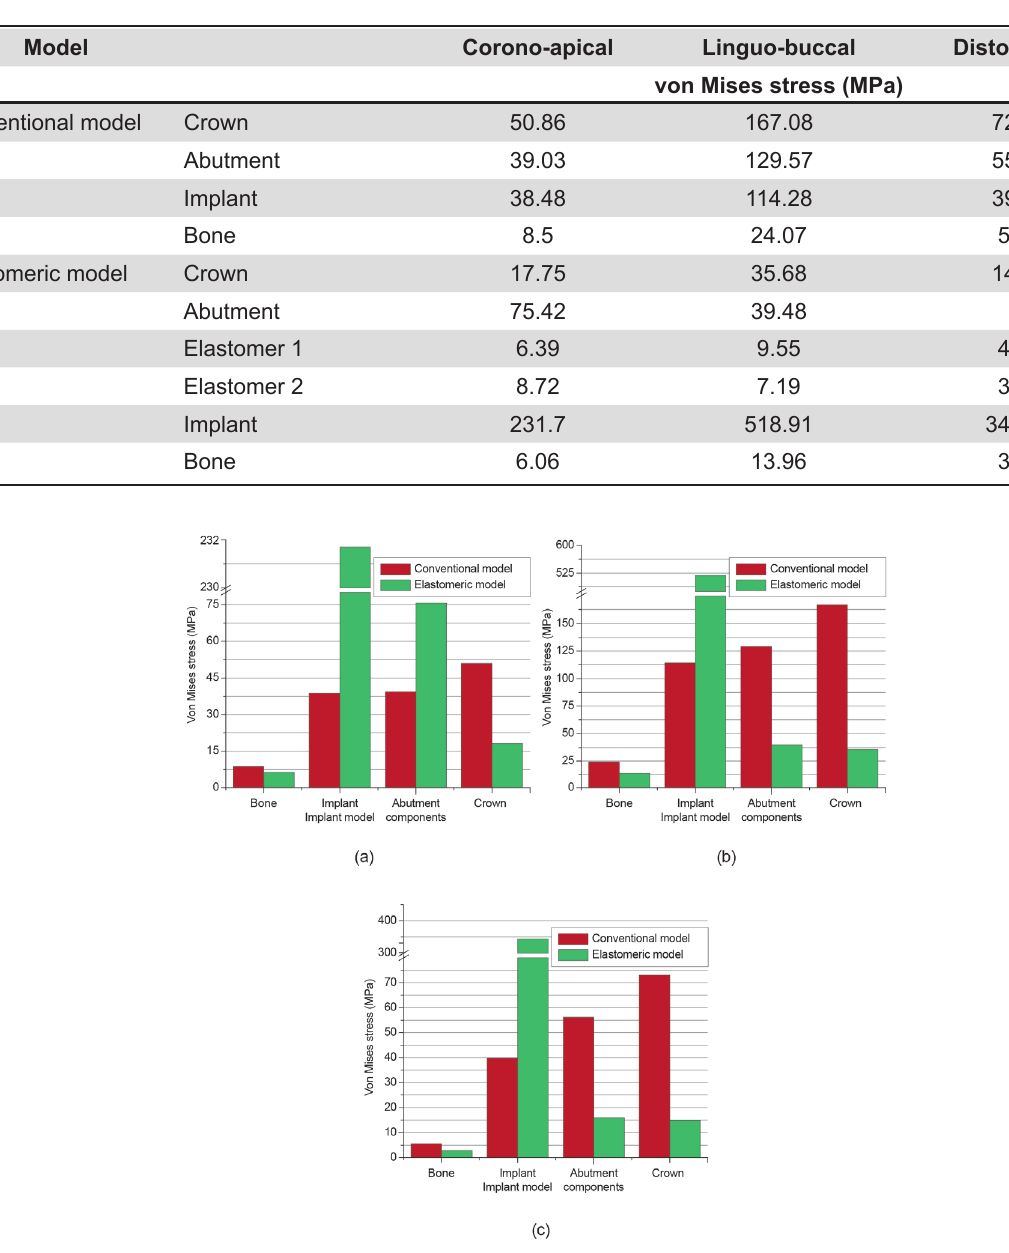
Table 3- Von Mises stress in the components of the two models under different load cases